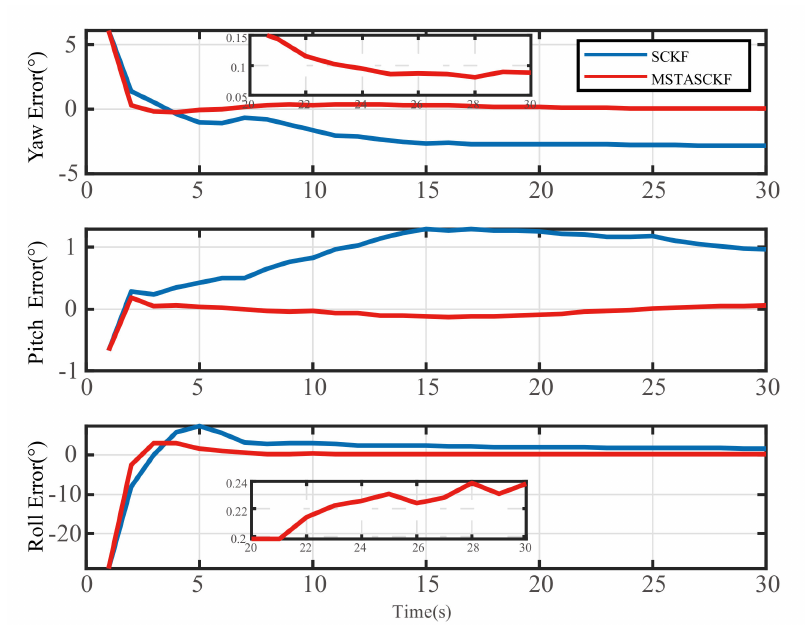
Figure 6. The attitude error comparison between MSTASCKF and SCKF.